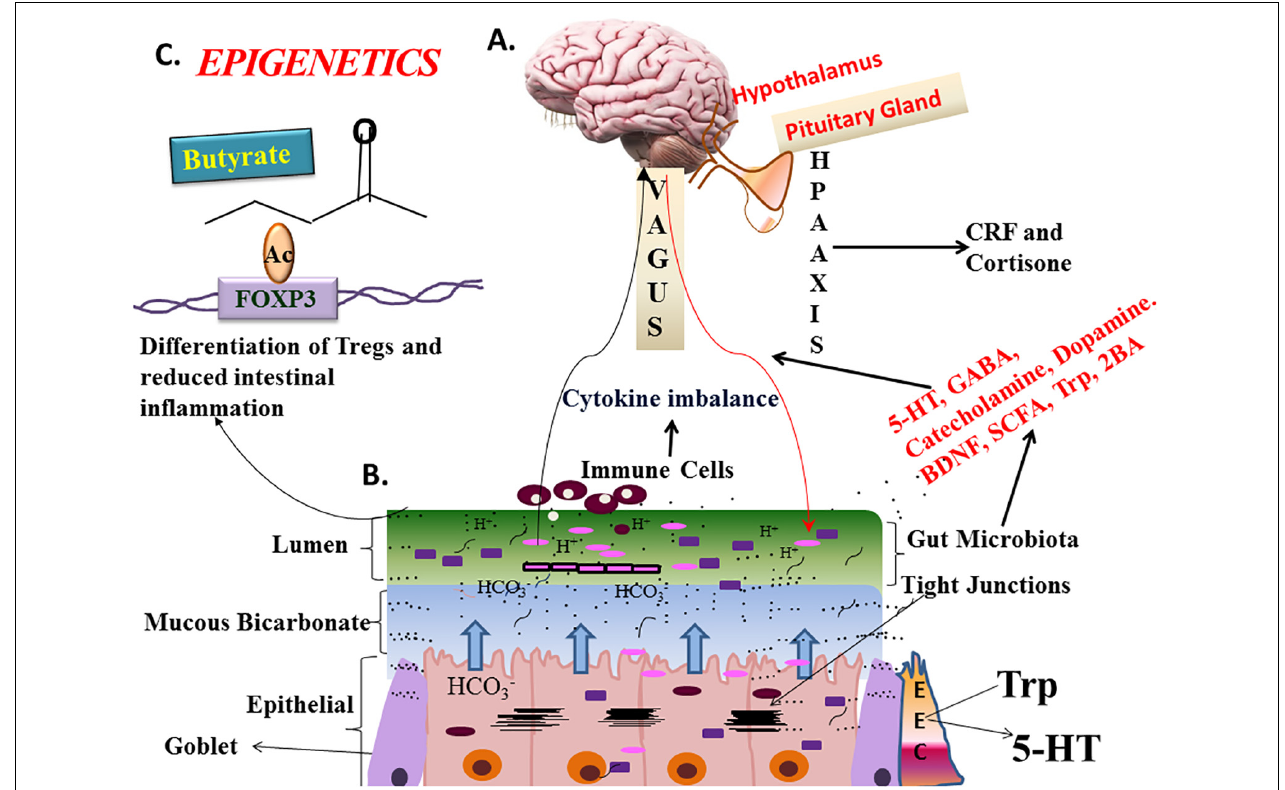
FIGURE 2 | State-of the–science-Gut-Brain-Bidirectional Axis (GBM). Three ways microbes communicate with GBM: neurobiochemical, neuroendocrinal, and neuroimmune mechanisms. Microbial sps can modulate hypothalamus-pituitary-adrenal gland (HPA) axis, by affecting corticotrophin releasing factor (CRF), and cortisone levels which can subsequently affect intestinal permeability and cause hypersensitivity. Neuroactive molecules like γ -aminobutyric acid (GABA), 5-HT, norepinephrine, and dopamine are produced independently by bacteria or through digestion of other food sources. Lactobacillus subspecies, Candida, Streptococcus, E. coli, and Enterococcus can make 5HT which affects sleep, appetite, mood, and cognition (Liu and Zhu, 2018). Clostridiales regulate synthesis and release of 5-HT by making tryptophan available (Martin et al., 2018) for its synthesis. Vagus nerve is the major connection between microbiome and gut, is imperative for GBM-axis. Microbial metabolites like short chain fatty acids, bile acids, and tryptophan can communicate between gut and brain directly or through vagal/spinal highways. Stress, dietary changes and microbiome can lead to cytokines imbalance and increases the risk of intestinal inflammation, IBD, and allergies, etc. Gut microbiota made metabolites like butyrate have epigenetic effect on FOXP3 (forkhead box P3) promoter of T-regs (Furusawa et al., 2013). Prebiotics like fructo-oligosaccharides and galacto-oligosaccharides increase BDNF, serotonin, GABAb receptor levels while reducing cortisone and L-Trp, hence have anti-anxiety and anti-depressant effect. Prebiotics and probiotics regulate the capacity of intestinal microbiota, preserve the integrity of the intestinal barrier (enteroendocrine cells), prevent bacterial translocation and regulate local inflammatory reaction through the intestinal related immune system. BDNF, Brain-derived Neurotrophic Factor; 5-HT, Serotonin; Trp, Tryptophan; SCFA, Short-chain fatty acid. (A) Showing human brain with detailed picture of hypothalamus and pituitary gland (B) . Showing the gastric mucosa lined by epithelial, goblet, and enterochromaffin cells (EEC), gastric mucosa is also showing bicarbonate buffer and lumen which has most of the microbiota (from Wikipedia) (C) . Showing the epigenetic effect of butyrate on FOXP3 promoter.